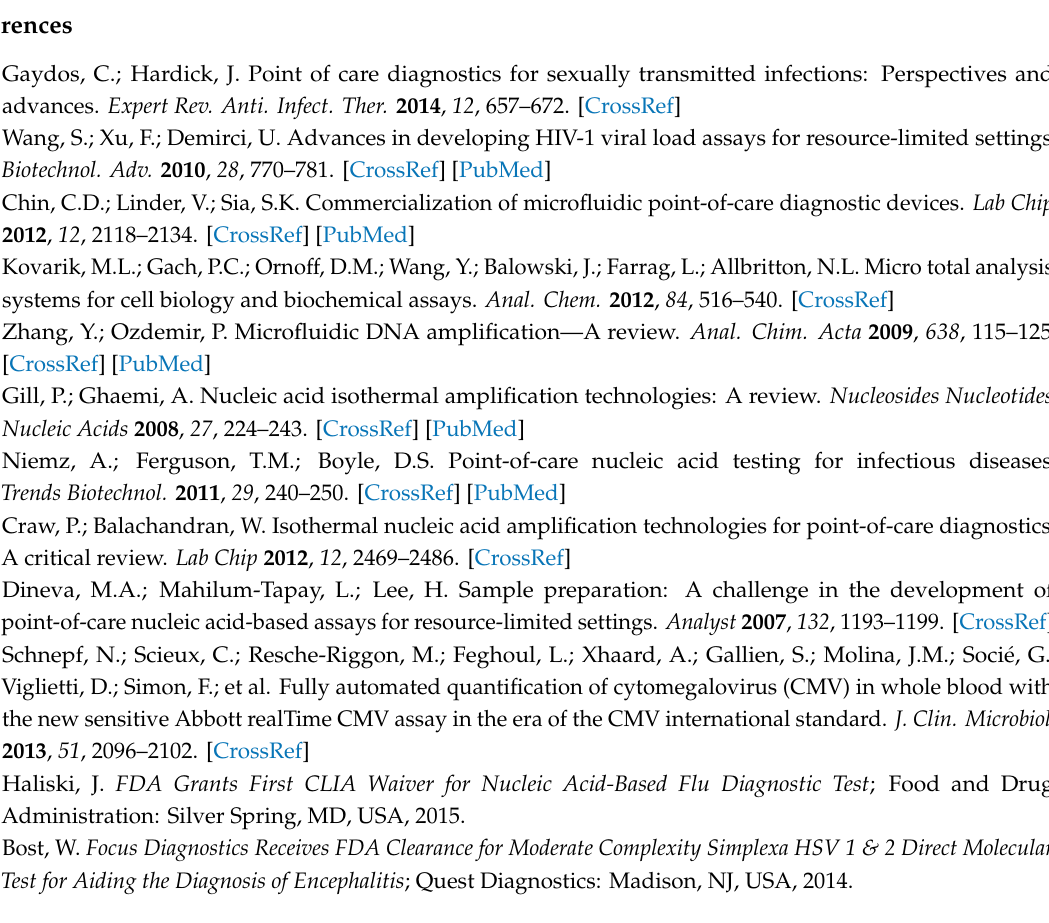
Table S1: Detailed Properties of Amplification